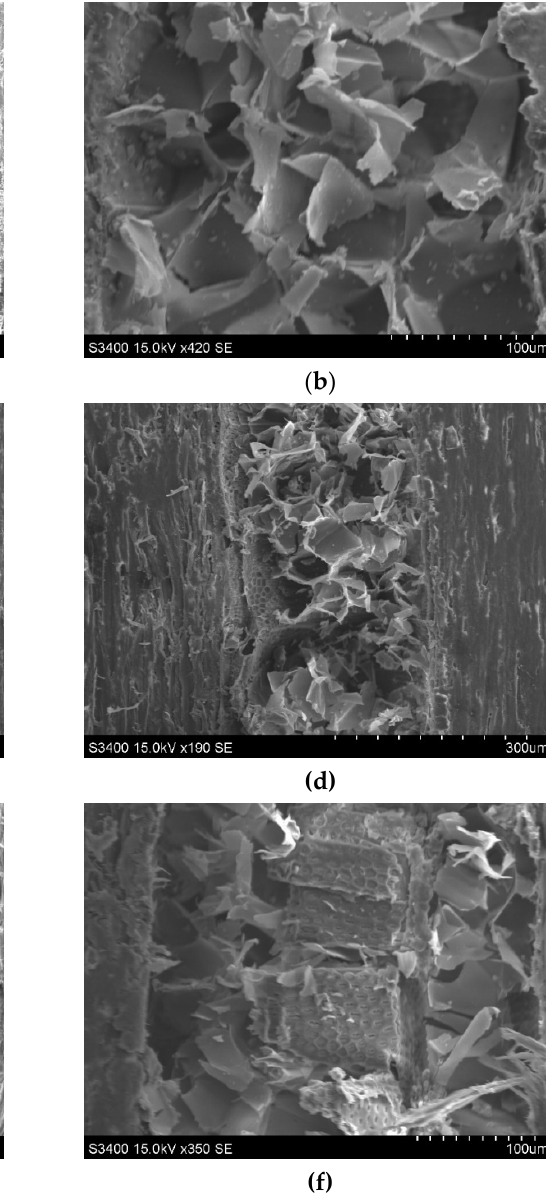
Figure 17. SEM view in longitudinal–radial section of wood: ( a ) control sample magnification × 80 SE; ( b ) control sample magnification × 420 SE; ( c ) sample T1 (first treatment) magnification × 60 SE; ( d ) sample T1 (first treatment) magnification × 190 SE; ( e ) sample T2 (second treatment) magnification × 150 SE; ( f ) sample T2 (second treatment) magnification × 350